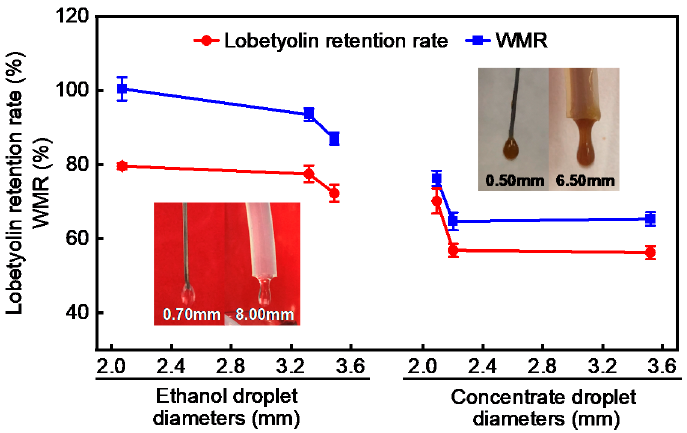
Figure 6. Results of lobetyolin retention rates and WMR values on different addition modes. The numbers below the droplet are the outer diameter sizes of the syringe needle or the silicone tube.